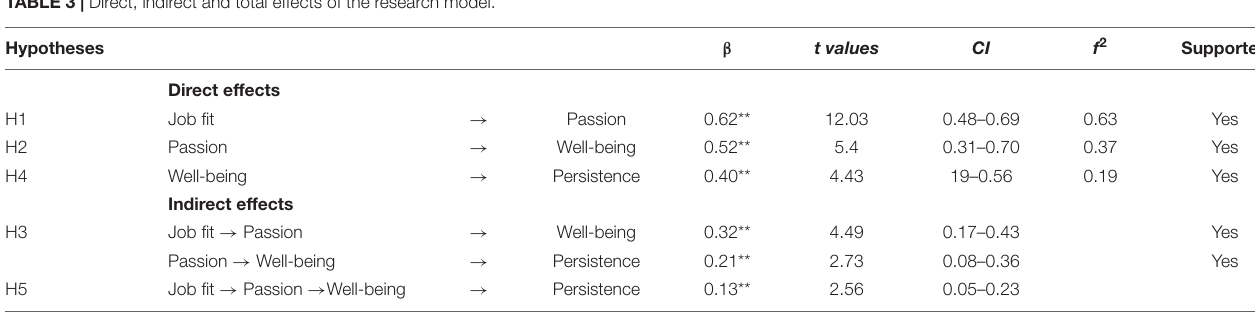
TABLE 3 | Direct, indirect and total effects of the research